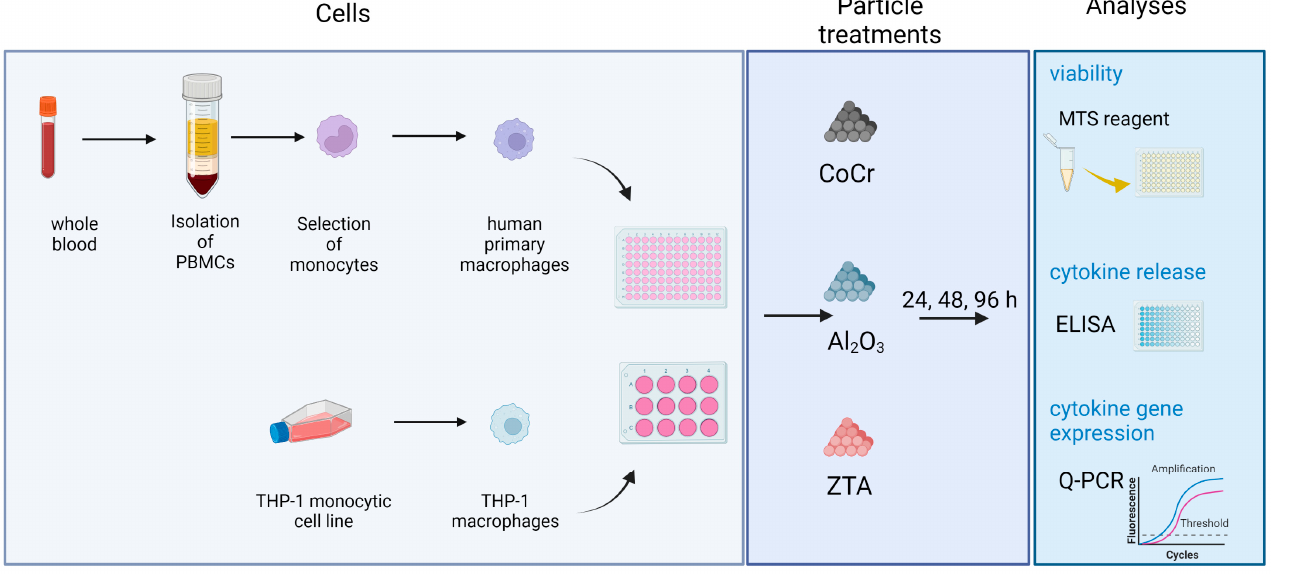
Figure 6. Schematic representation of the experimental design of this study. The figure was created with Biorender.com.